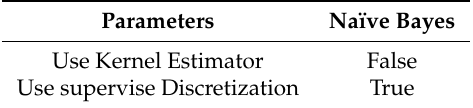
Table 2. Naïve Bayes Classifier parameters used in this